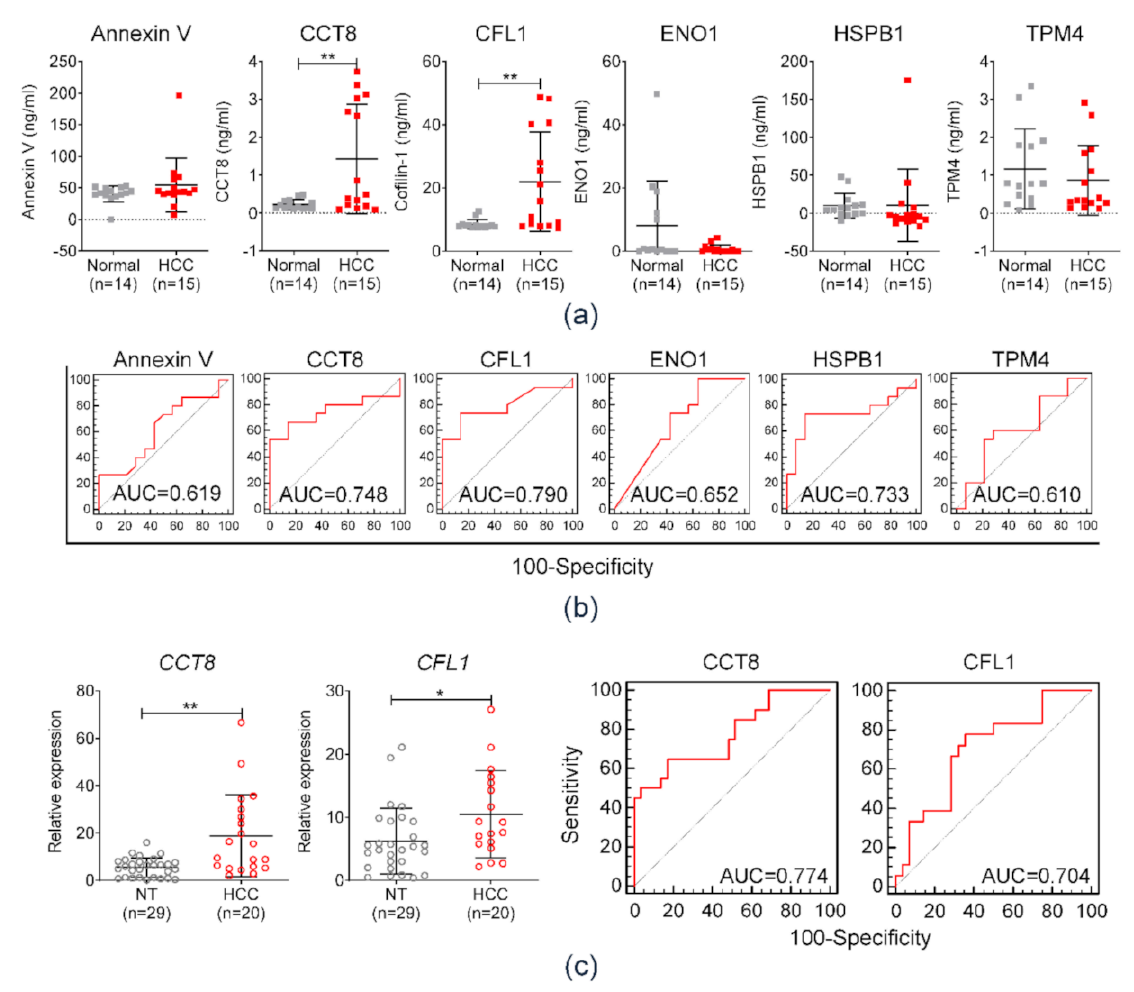
Figure 4. Diagnostic efficiency of annexin V, CCT8, CFL1, ENO1, HSPB1, and TPM4 in diagnosing HCC in the test cohort comprised of normal healthy individuals (normal) and patients with HCC. ( a ) Comparison of the six protein expressions between 14 healthy individuals (normal) and 15 patients with HCC. ( b ) Area under the curve (AUC) and receiver operating characteristics (ROC) of six protein markers in diagnosing HCC. ( c ) Left panel: relative expression of CCT8 and CFL1 in serum exosomal mRNA of 29 healthy individuals (normal) and 20 patients with HCC. Right panel: area under the curve (AUC) and receiver operating characteristics (ROC) of serum exosomal CCT8 and CFL1